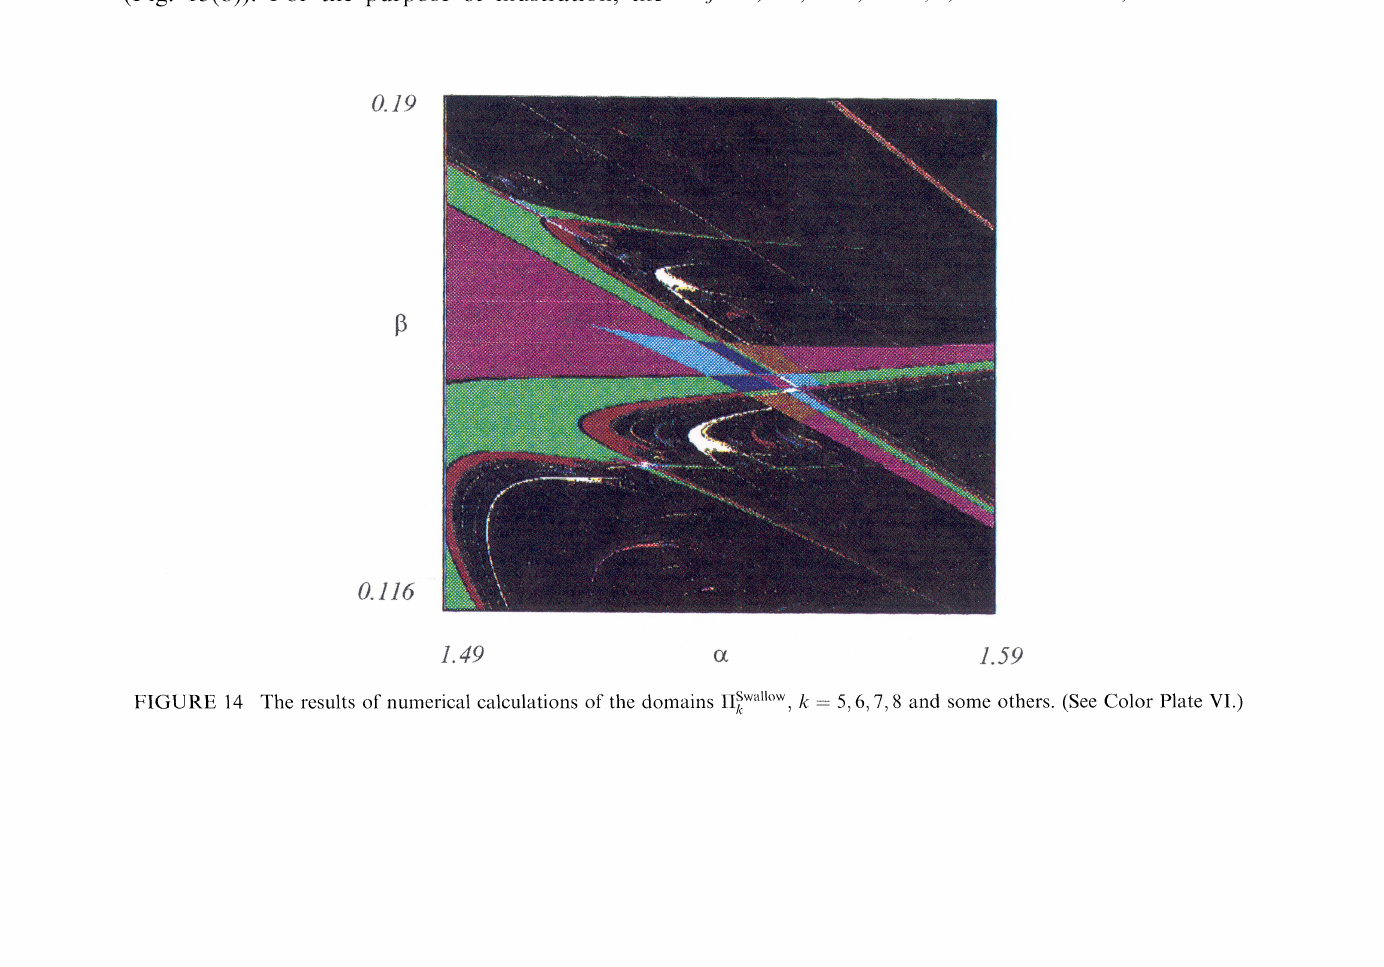
FIGURE 14 The results of numerical calculations of the domains nSwllow k 5, 6, 7 8 and some others. (See Color Plate